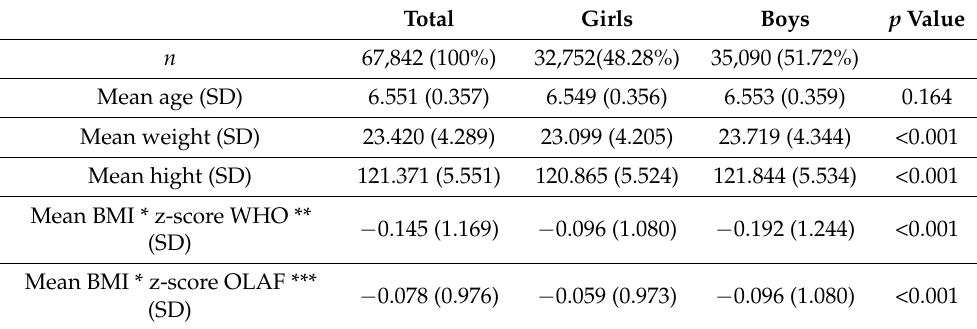
Table 1. Characteristics of the study group. Total Girls Boys p